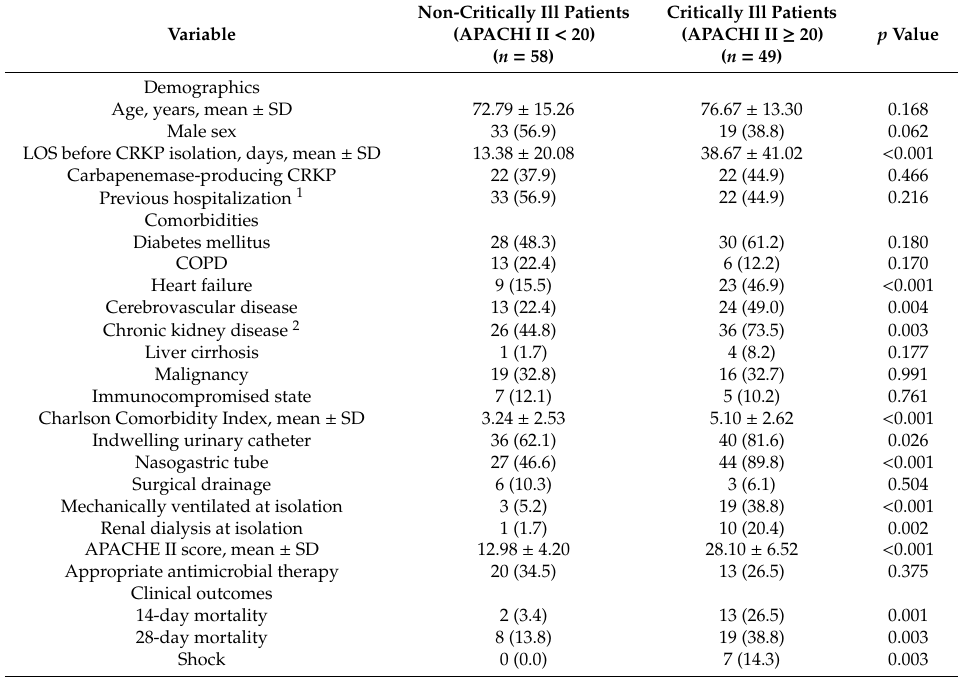
Table 4. Clinical characteristics and outcomes of non-critically ill and critically ill patients with CRKP bacteriuria.